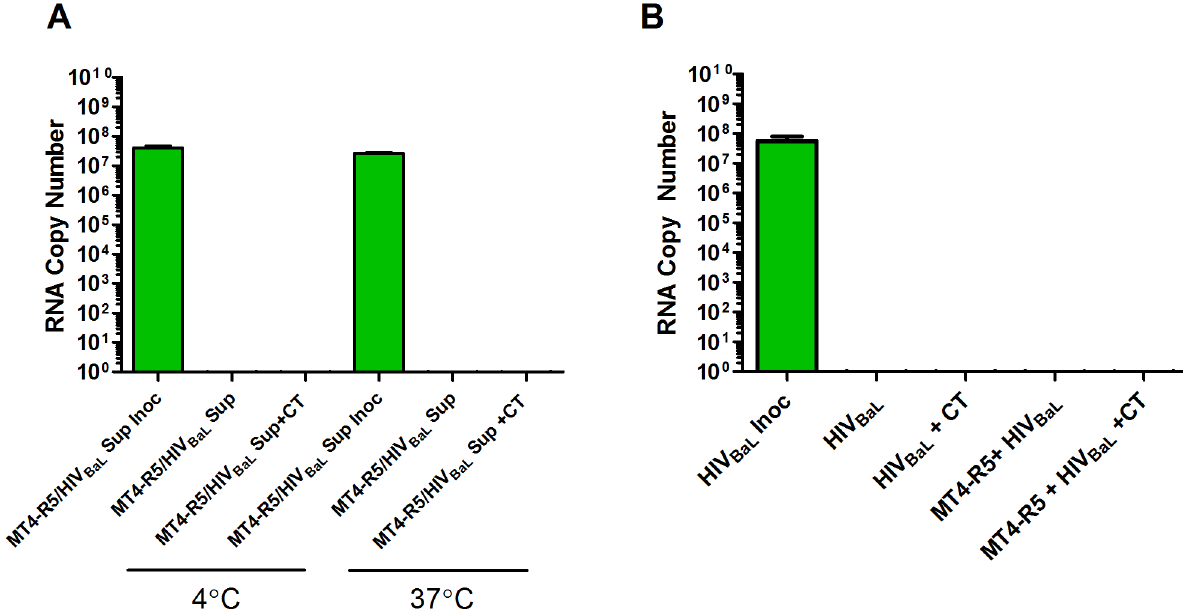
Fig 4. Cell-associated HIV BaL migration is likely dependent upon epithelial cell contact with an HIV-infected T cell. A2EN cells were infected with CT serovar D for 72 h. ( A ) 1000 TCID 50 of cell-free HIV BaL freshly produced by MT4-R5 was added to apical chambers of mock and CT infected cells for 3 h at 4°C or 37°C. ( B ) 1000 TCID 50 of PM-1-derived cell-free HIV BaL was added to mock and CT-infected A2EN cells in the presence or absence of 1 x 10 6 uninfected MT4-R5 cells. After a 3 h at 37°C, basolateral supernatants were collected and viral RNA was enumerated using PCR. Bars represent the mean RNA copies ± SD. Data is representative of 3 independent experiments, each performed in quadruplicate. * p < 0.05.